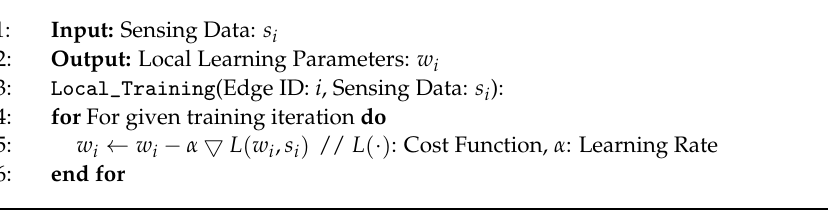
Figure 3. Flowchart of the overall system. Algorithm 1 Fair Federated Learning Computation at Edge Server i .